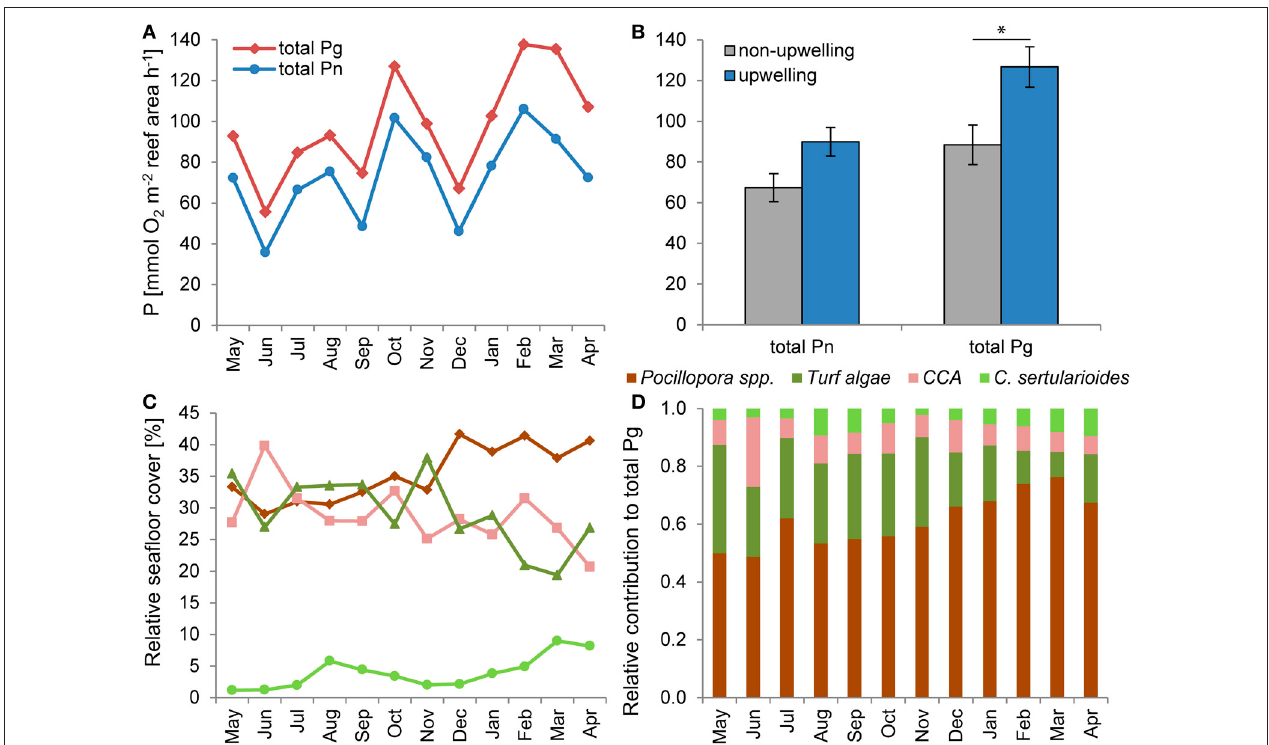
FIGURE 4 | Reef-wide primary production. (A) Total reef-wide net (total Pn) and gross primary production (total Pg) from May 2013 to April 2014 at a monthly temporal resolution and (B) comparing non-upwelling (May 2013–January 2014) and upwelling conditions (February–April 2014). (C) Relative seafloor cover of dominant primary producers over the year of observation and (D) their relative contribution to monthly total Pg calculated from (A, C) . * p < 0.05